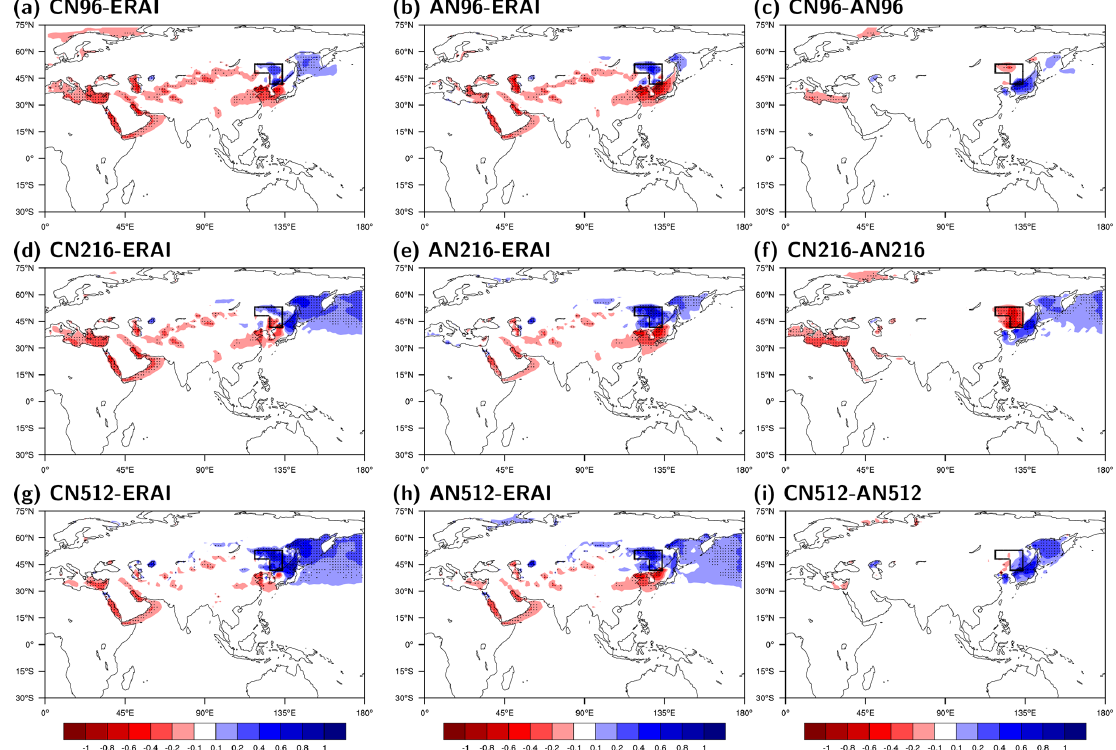
Figure 10. Difference in moisture source for region 5 in DJF (units: